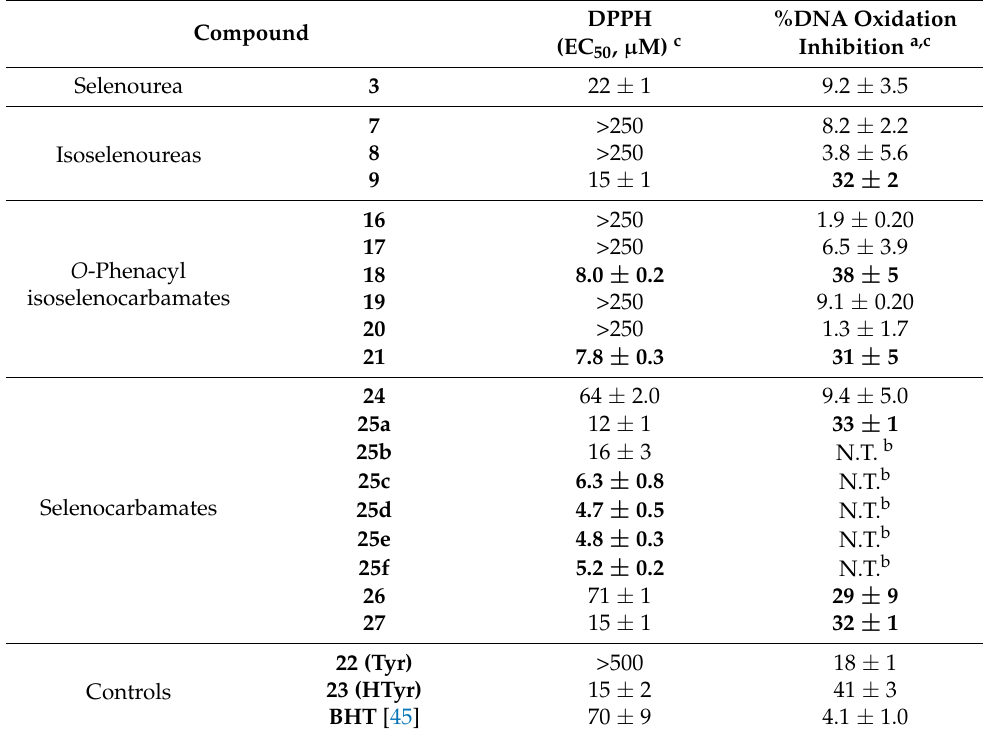
Table 1. Antioxidant assays for organoselenium derivatives.